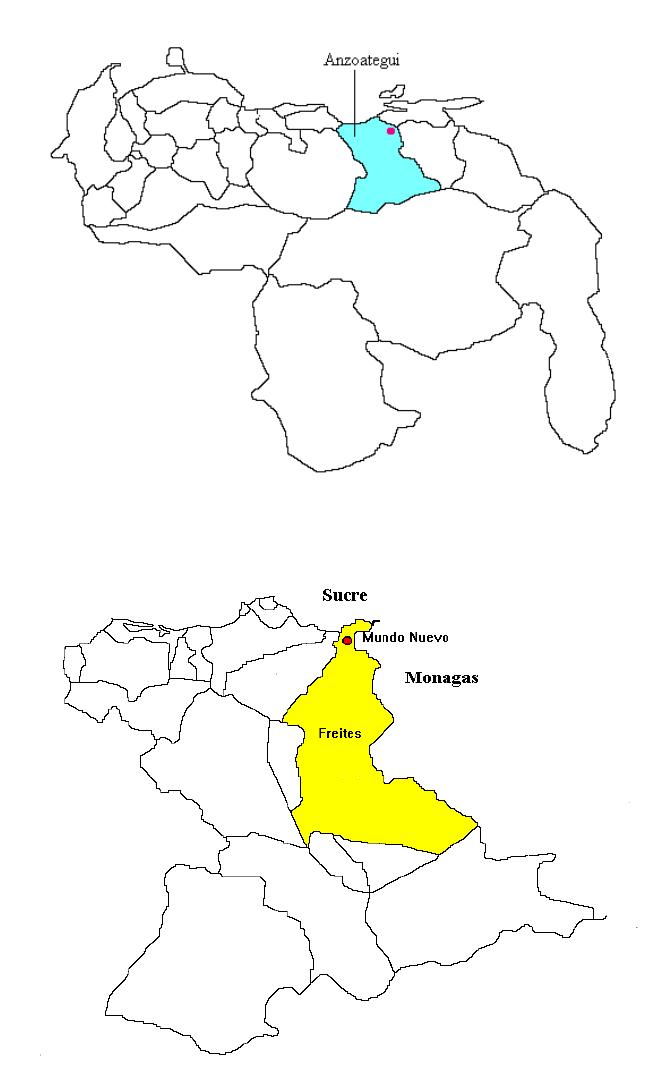
Figure 1 . Relative geographical location of Tityus gonzalespongai n. sp . in “La Piedra de Mundo Nuevo” village, Freites municipality, Anzoátegui State (at the border of Monagas and Sucre States),